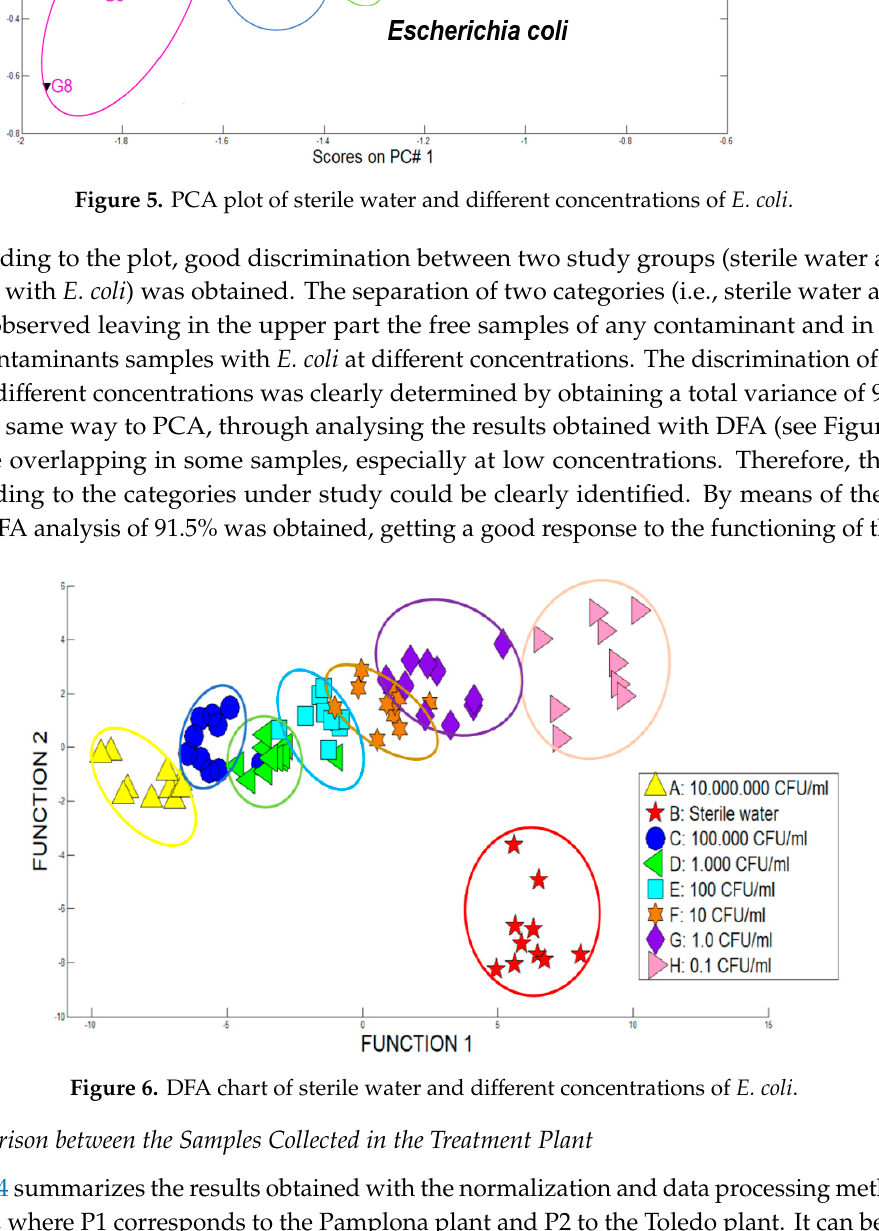
Table 4. Results of the methods of normalization and data processing.